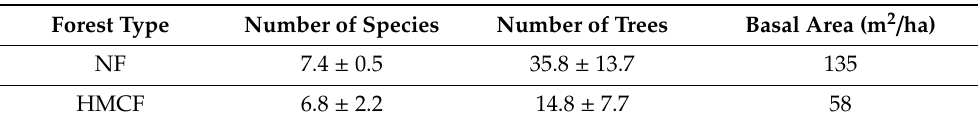
Table 3. Summary of tree biodiversity survey results. The trees with diameter at breast height (DHB) larger than 5 cm were only selected for the